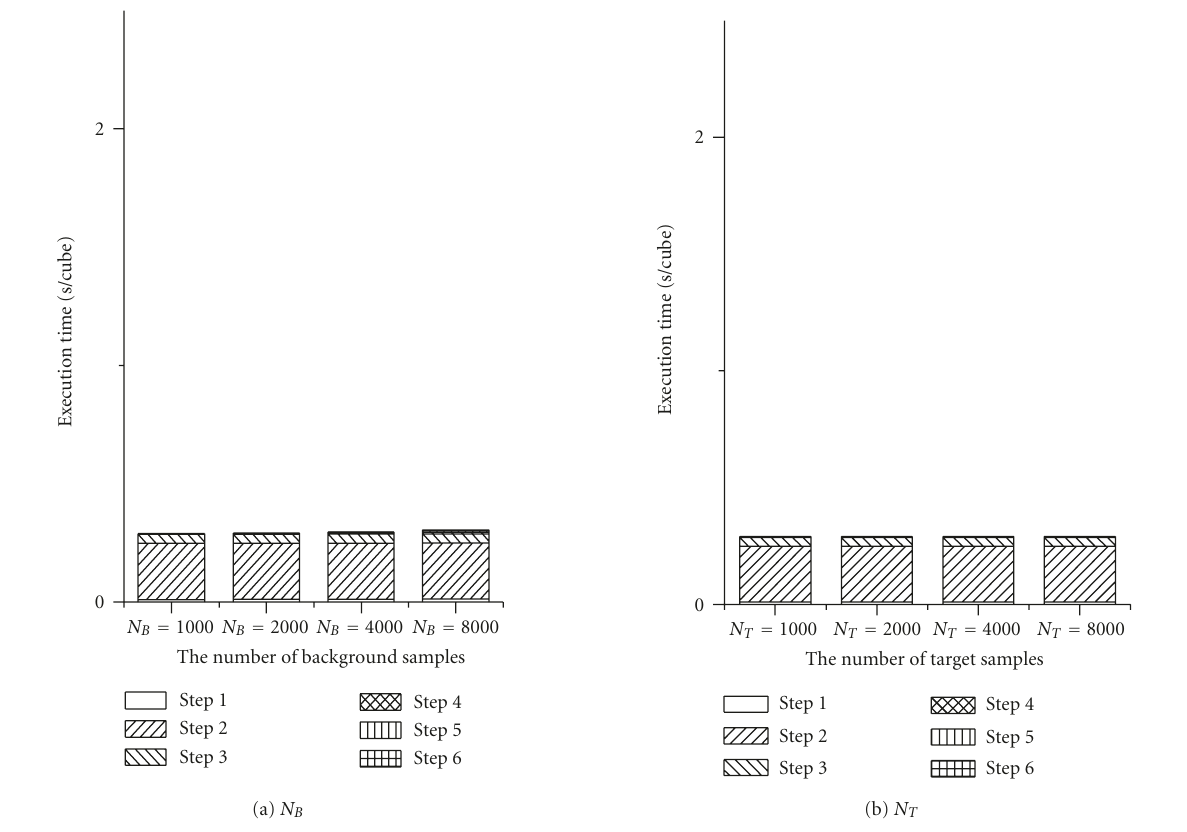
Figure 23: The execution time in function of number of background samples or the number of target samples, where (a) N E = 4, N lib = 3, N N N N N = 3, N x = 820, N y = 748, N B = x = 820, y = 748, T = 1000; (b) E = 4, lib